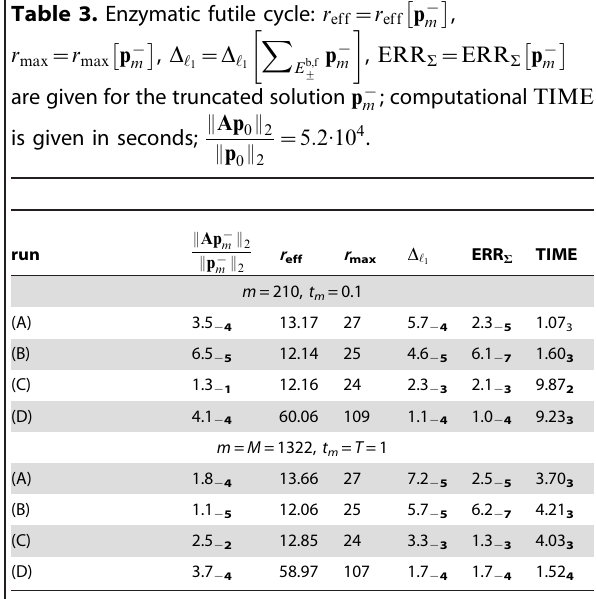
Table 3. Enzymatic futile cycle: r eff ~ r eff p {